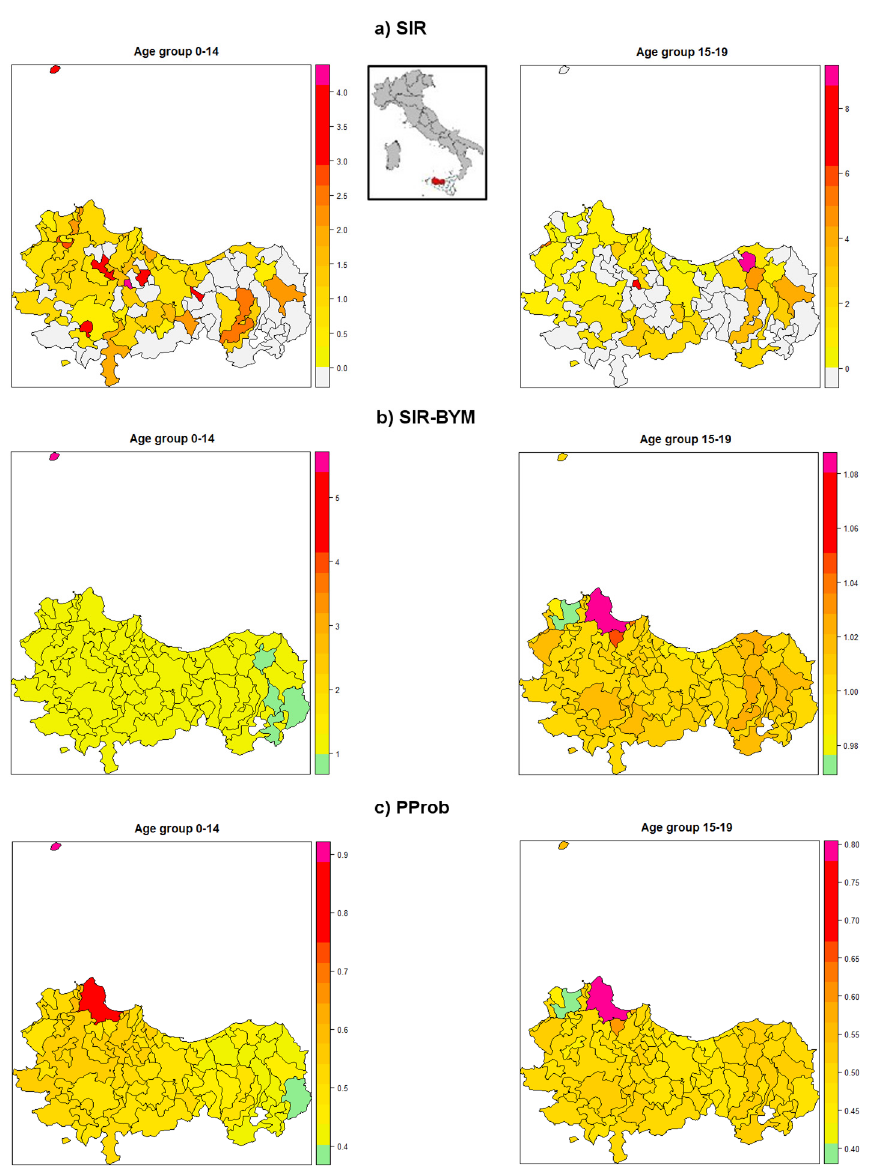
Figure 3. Spatial analysis of ( a ) SIRs of “all tumours”; ( b ) BYM estimates and their ( c ) post-probabilities by municipality and by children and adolescent cancers. Palermo Province (males and females together), 2003–2012. SIR: Standardized Incidence Ratio; SIR-BYM: estimates of SIRs from Besag-York-Mollie Bayesian model; PProb: post-probabilities of BYM models.